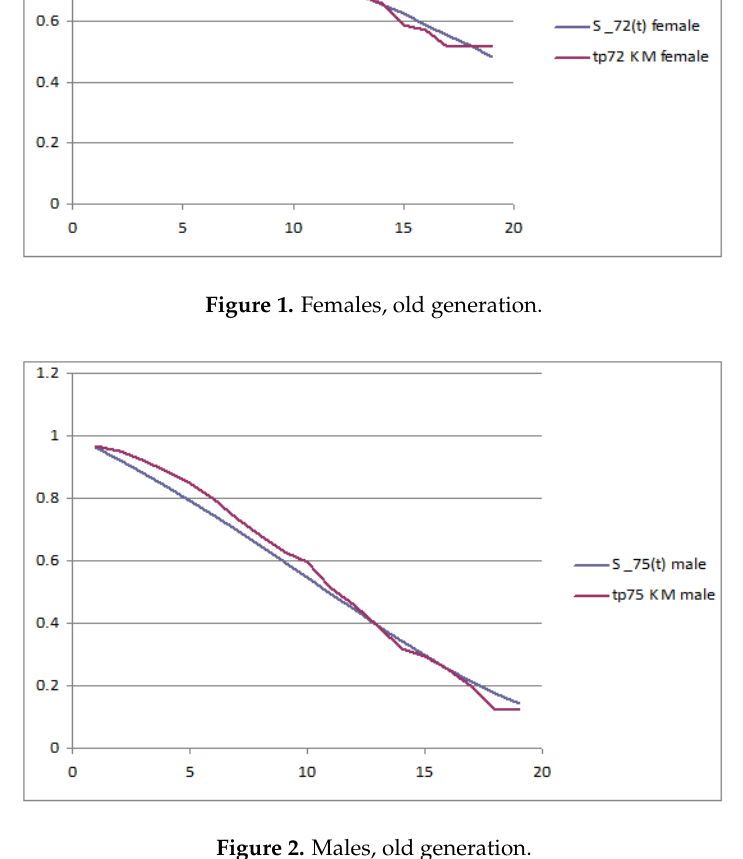
Figure 2. Males, old generation.